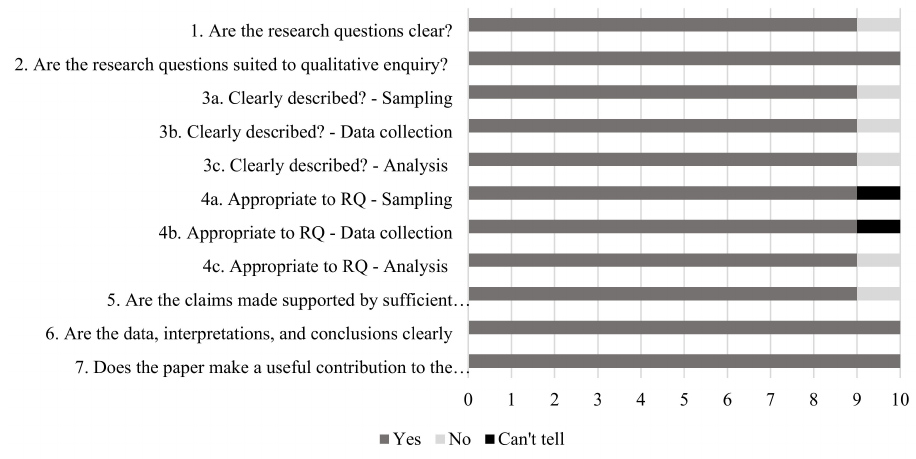
Figure 5. Trustworthiness of qualitative studies by assessment